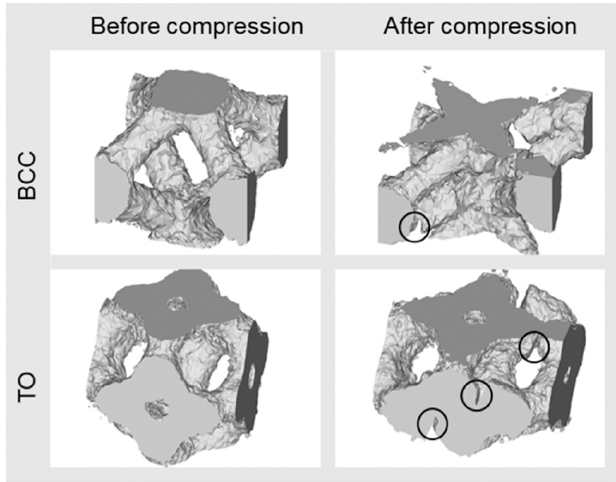
Figure 8. X-ray computed tomography (CT) reconstruction models and cross-section images of 20% compressed lattice structures.